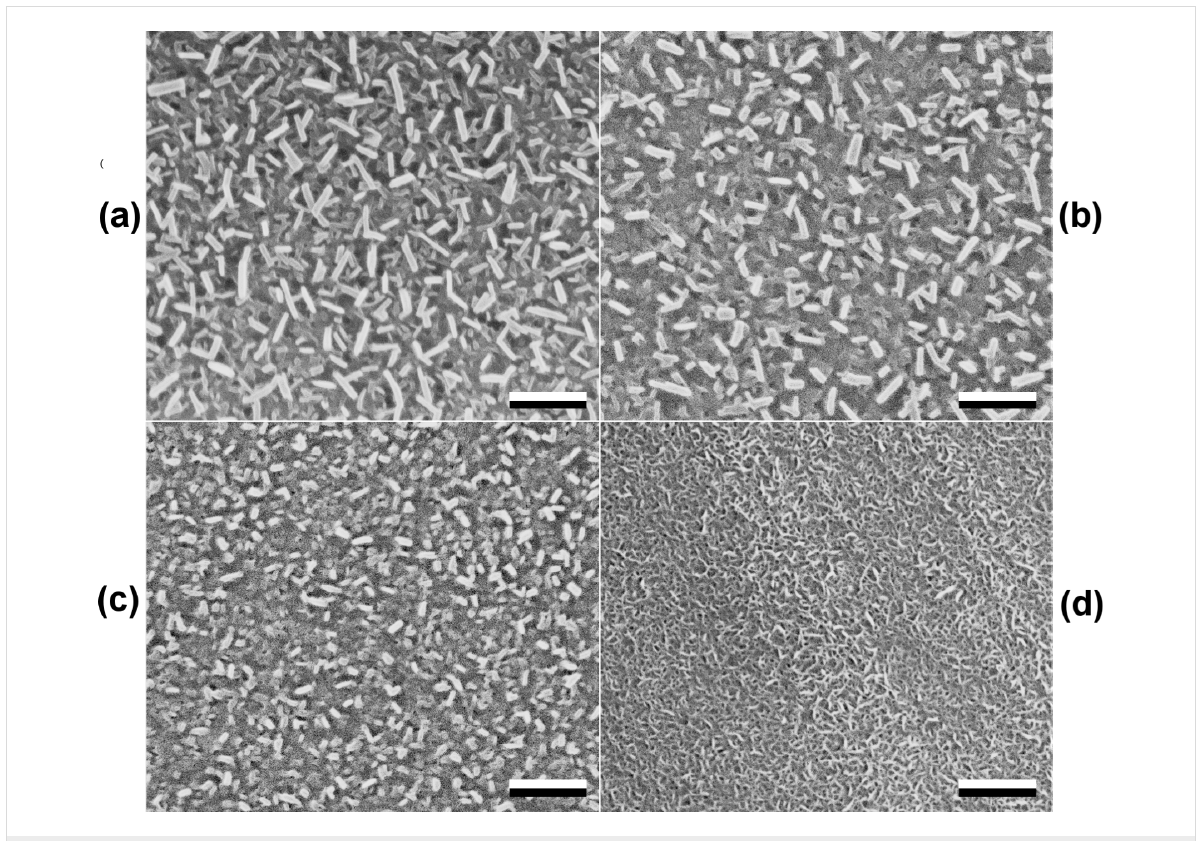
Figure 1: Scanning electron microscopy (SEM) micrographs of wax surfaces formed by alkanes of varying chain lengths: C 36 H 74 (a), C 40 H 82 (b), C